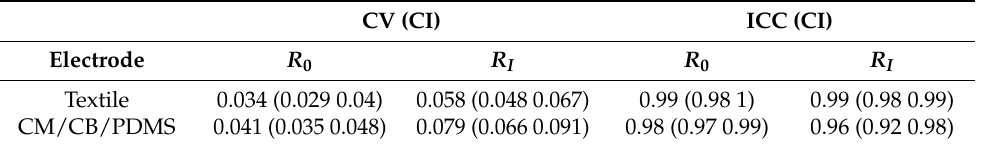
Figure 8. Intra-subject measurements for a given subject. Left: textile electrodes. Right: CM/CB/PDMS electrodes. Table 4. Intra-subject consistency analysis results.